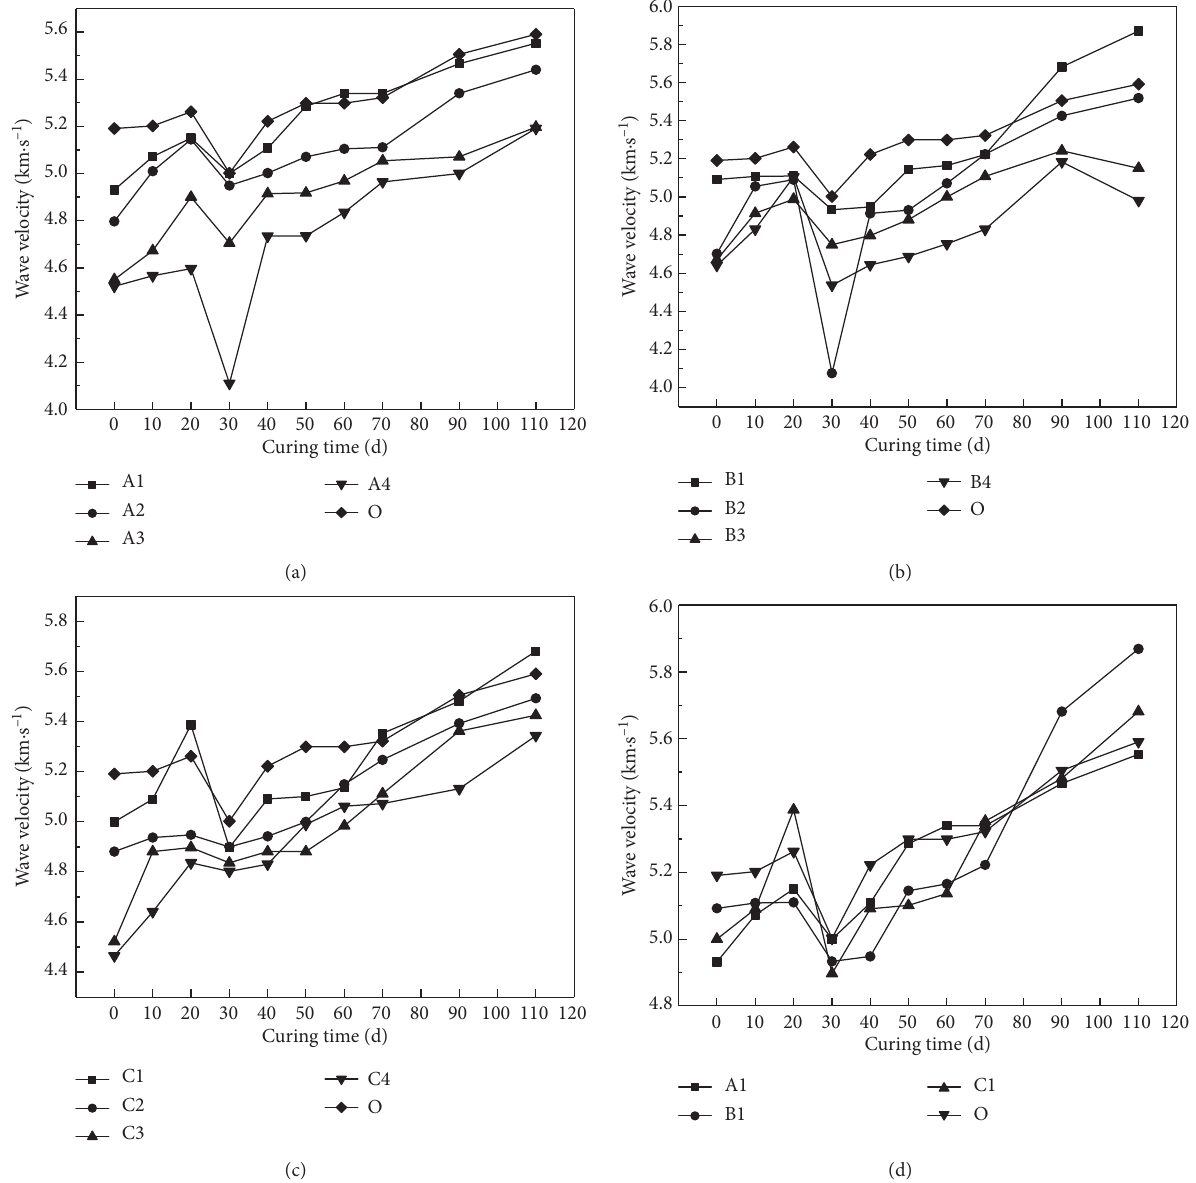
Figure 2: Wave velocity of rubber concrete after chloride erosion: (a) 20 mesh, (b) 1 ∼ 3mm, (c) 3 ∼ 6mm, and (d) 5%